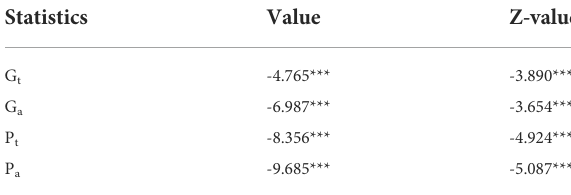
TABLE 5 Statistical fi ndings of panel cointegration test (Westerlund,